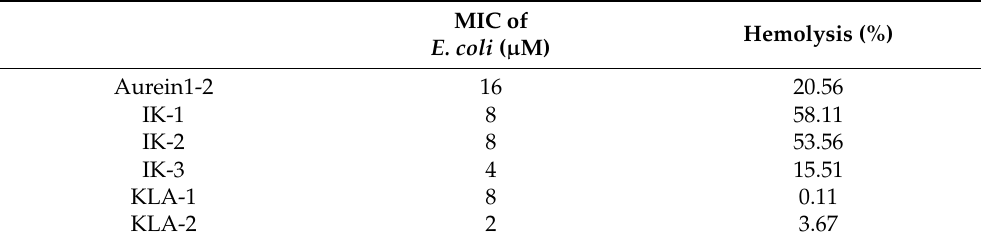
Table 5. The hemolysis percentages of aurein 1.2 and its analogs at its MIC value for E. coli . MIC